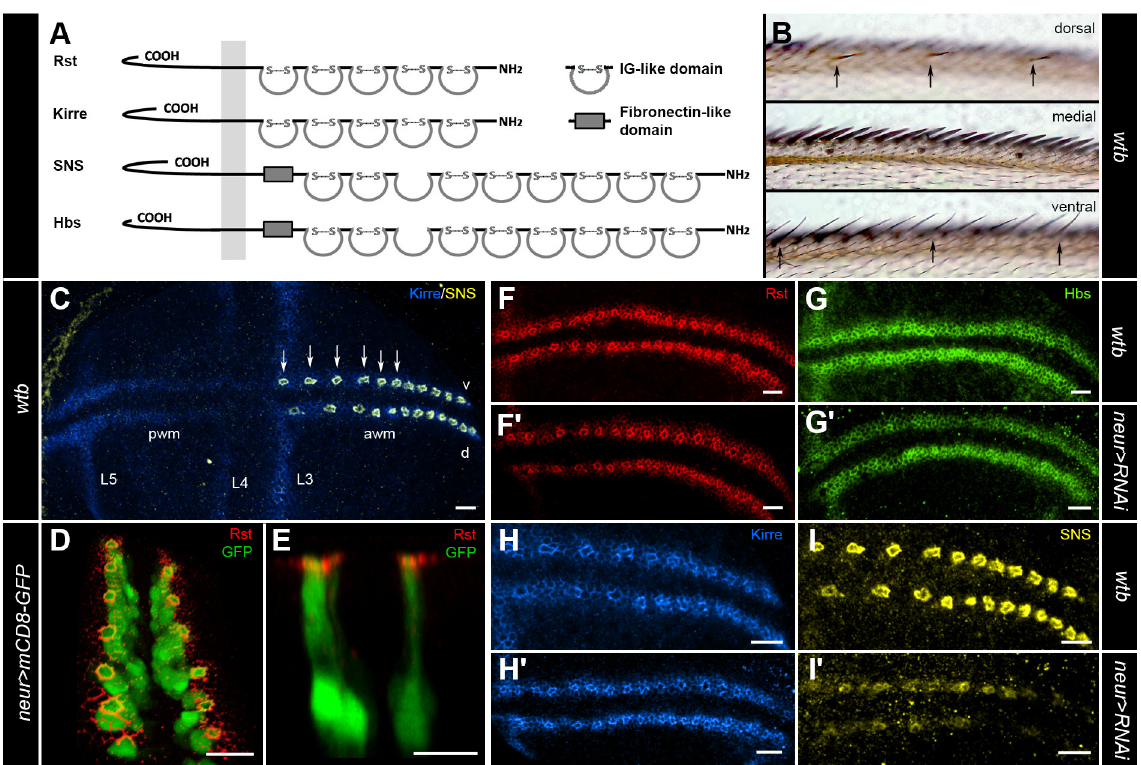
Fig 1. The IRM-proteins Rst, Hbs, Kirre and SNS are expressed in distinct patterns during the development of sensory bristles in the anterior wing margin. (A) The Drosophila IRM-proteins consist of the Neph-like proteins Rst and Kirre and of the Nephrin-like proteins Hbs and SNS. (B) Representative image showing the three bristle rows of the anterior wing margin [5]. The dorsal row consists of recurved bristles marked with an arrow. The medial row consists of mechanosensory stout bristles. The ventral row is composed of mechanosensory slender bristles and recurved bristles marked with an arrow. (C) Representative image of the presumptive wing margin of a late third instar larvae. Kirre in blue can be found in the presumptive posterior wing margin (pwm), anterior wing margin (awm) and the wing veins L3, L4 and L5. SNS in yellow can be only found in the SOPs of the awm. Six example SOPs are marked with an arrow. The ventral (v) side faces up and dorsal (d) faces down. (D-E) The apical localization of the IRM-protein Rst (red) is shown in third instar larvae of the genotype neur-GAL4 > UAS-mCD8-GFP (green). The SOPs are specifically marked by GFP. The images show a 3D reconstruction in (D) and a lateral view (E). (F-I) Localization of the IRM-proteins in the awm of third instar larvae. Rst (F) in red is localized in two adhesive belts in the awm and is enriched at the border to the SOPs of the recurved bristles. neur-GAL4 > UAS-rst-RNAi shows no effect on the enrichment of staining around the SOPs (F ’ ). A similar staining pattern in green can be seen for Hbs in wild type (G), but the SOP specific RNAi shows a reduction of staining around the SOP borders (G ’ ), indicating Hbs expression inside the SOPs. Kirre in blue (H) shows a similar pattern as Rst and SOP specific RNAi has no effect (H ’ ). SNS (I) in yellow can only be found at the border of the SOPs. neur-GAL4 > UAS-sns-RNAi reduces SNS in the SOPs (I ’ ). Scale bars correspond to 10 μ m in all images.